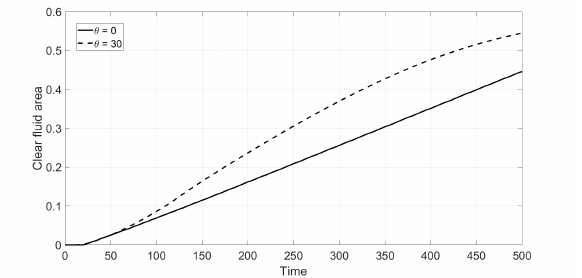
Figure 11. Reduced volumetric rate V ( t ) of the clear fluid zone c = 0 versus dimensionless time for the inclination angles α = 30 ◦ from the bottom upwards: non-Newtonian